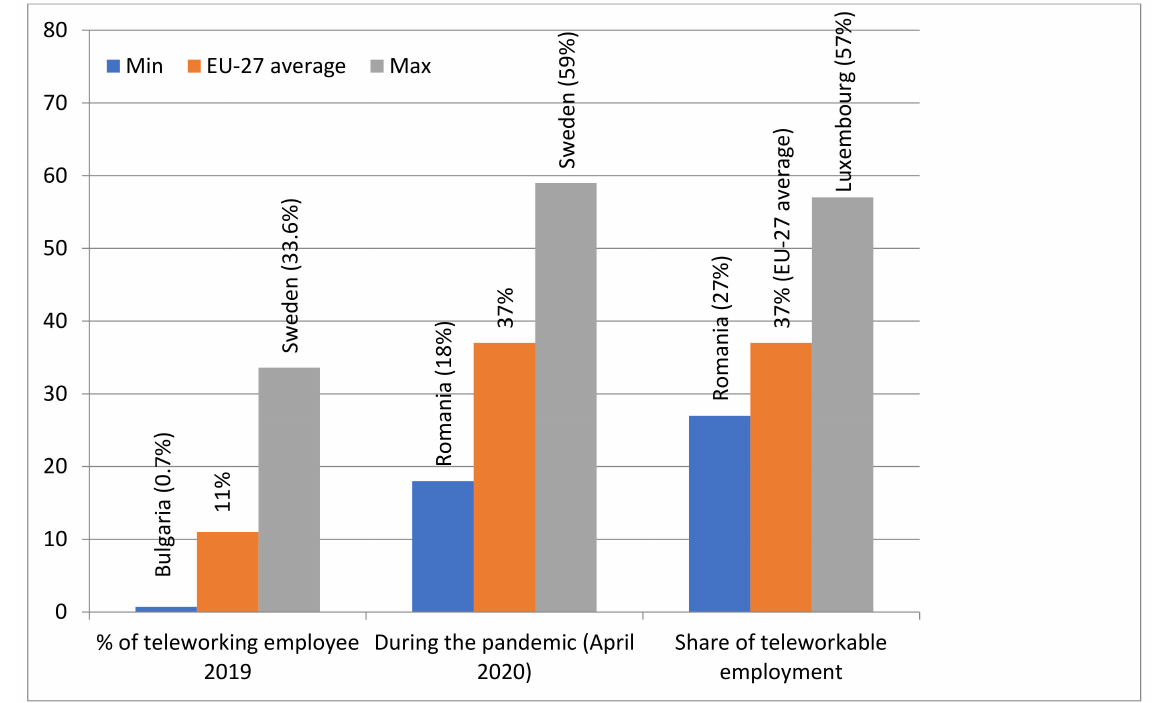
Figure 2. Changing the percentage of employees who use telework before and during the Covid-19 pandemic. Source: Authors’ elaboration from